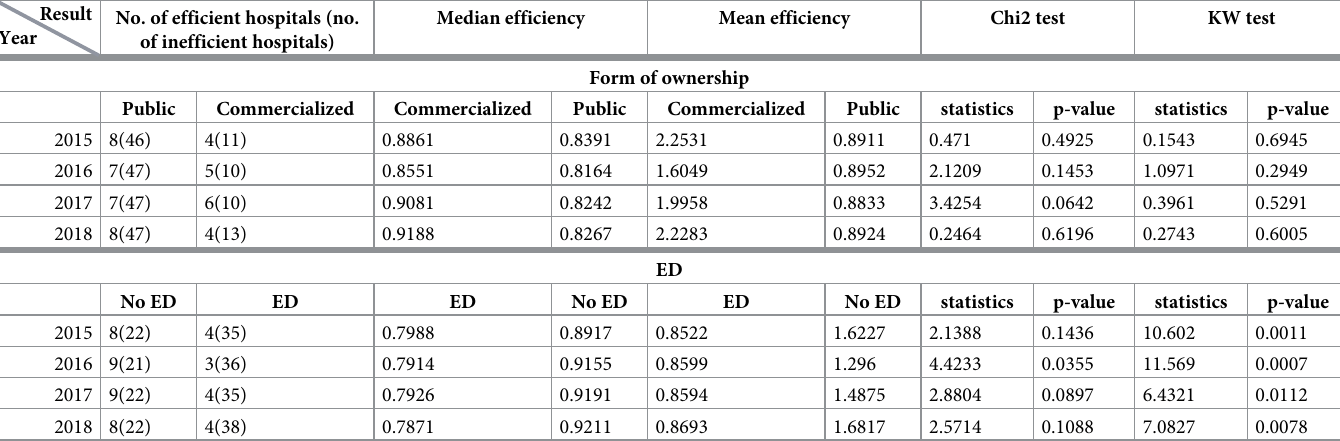
Table 13. Efficiency of hospitals with an ICU with respect to the form of ownership and ED ( traditional approach). Result Year